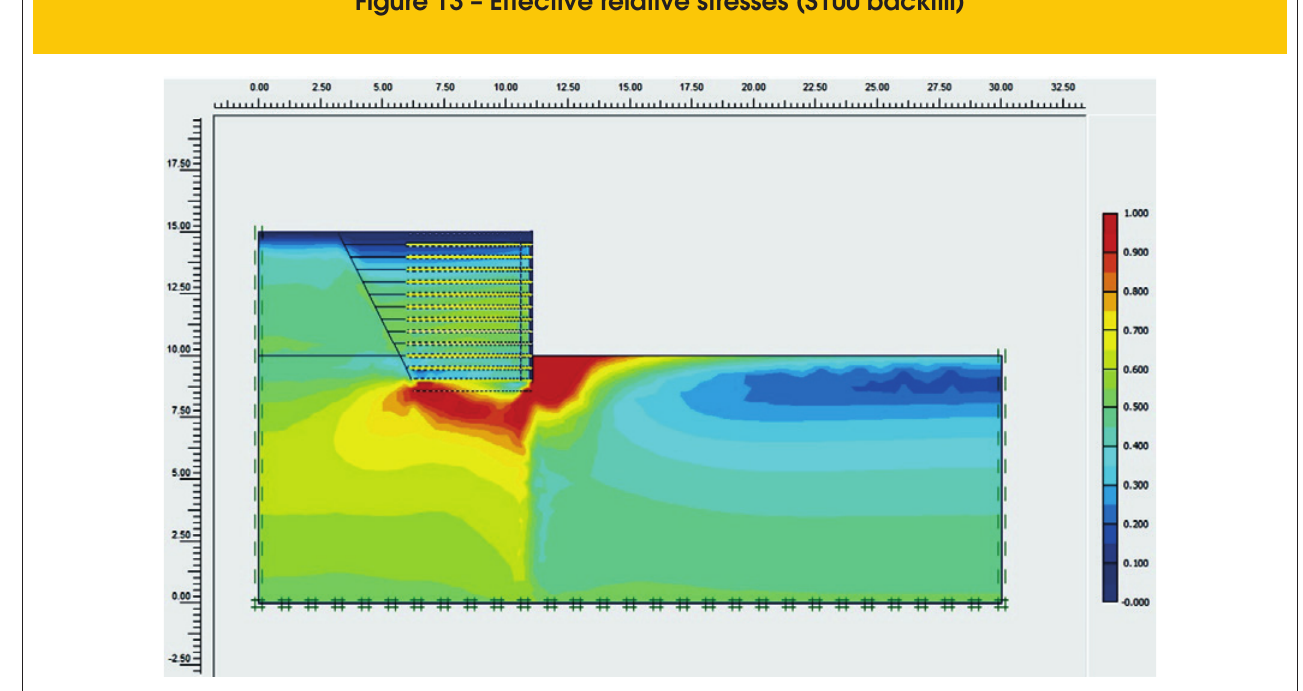
Figure 13 – Effective relative stresses (S100